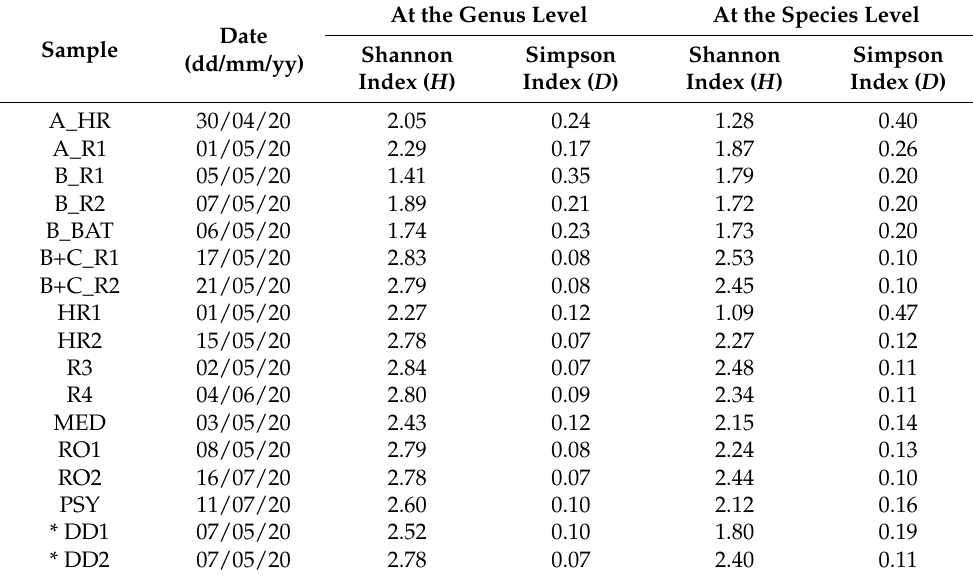
* The date represents the starting sampling date since both samples were collected by dry deposition over 14